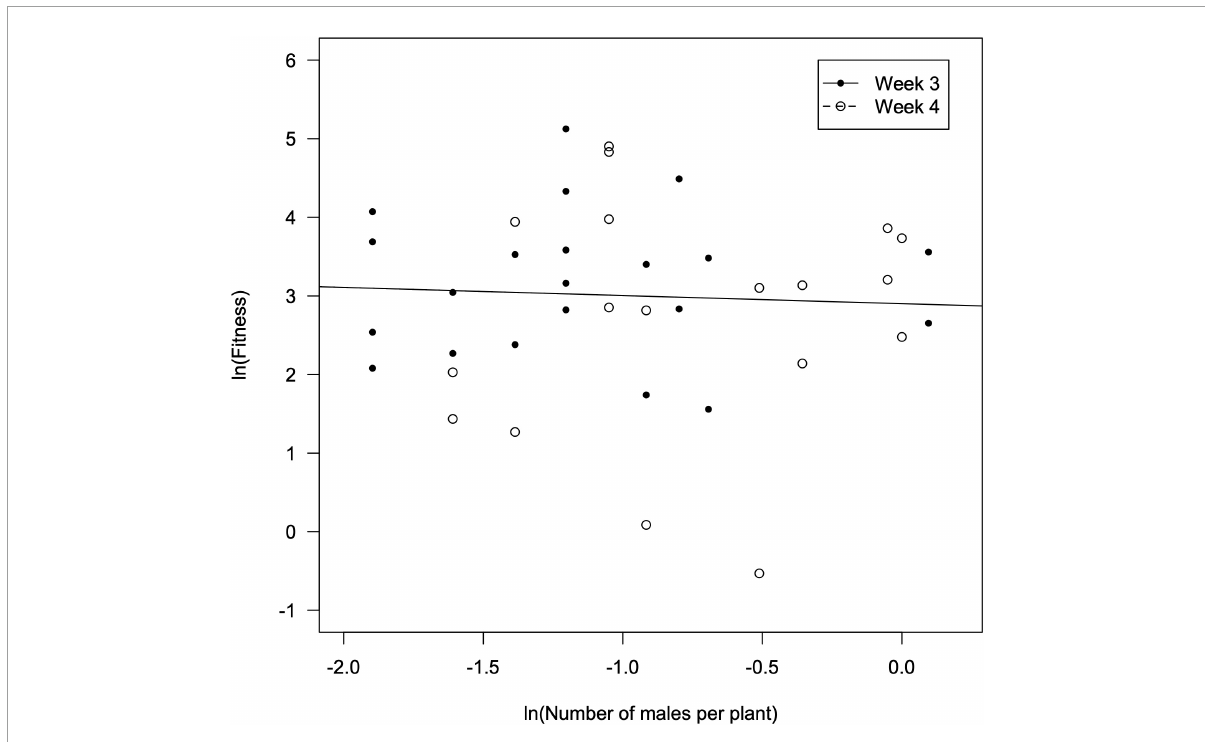
FIGURE4 Fitness of D. hesperus females (offspring per female) vs. the number of males per plant as observed in the third and fourth weeks since the introduction of tomato plants in the